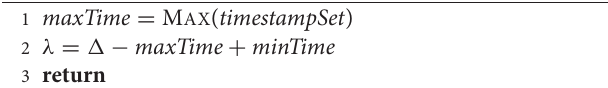
Algorithm 2 | U PDATE B OUNDS ( timestampSet , 1 , minTime